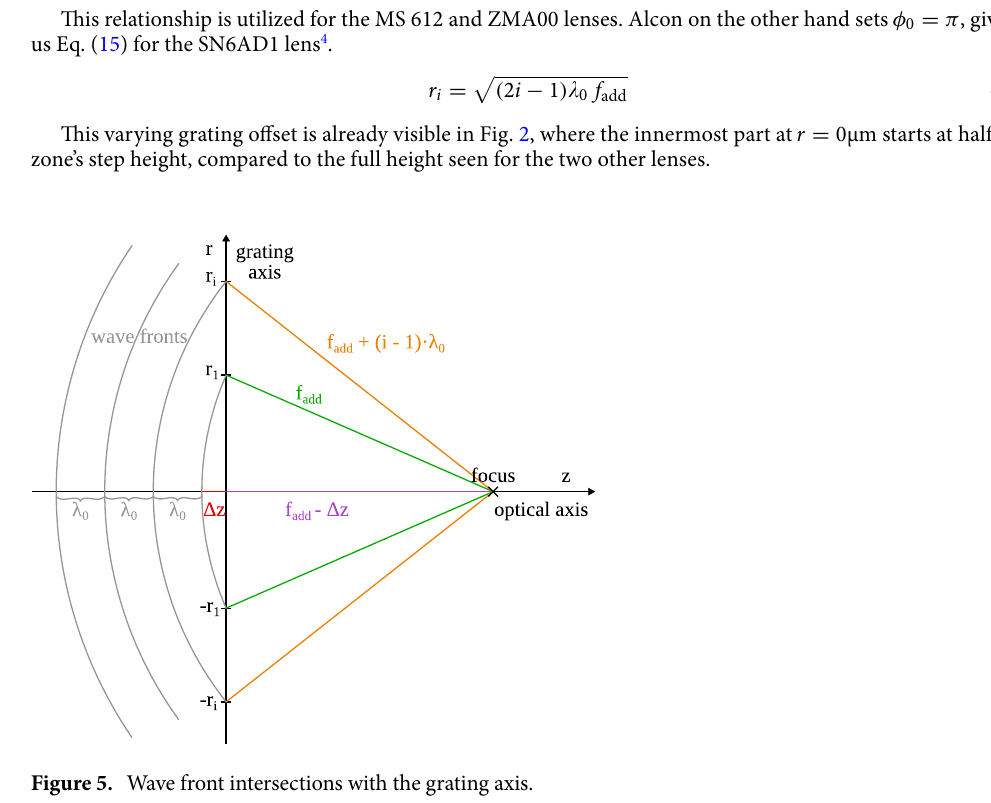
Figure 5. Wave front intersections with the grating